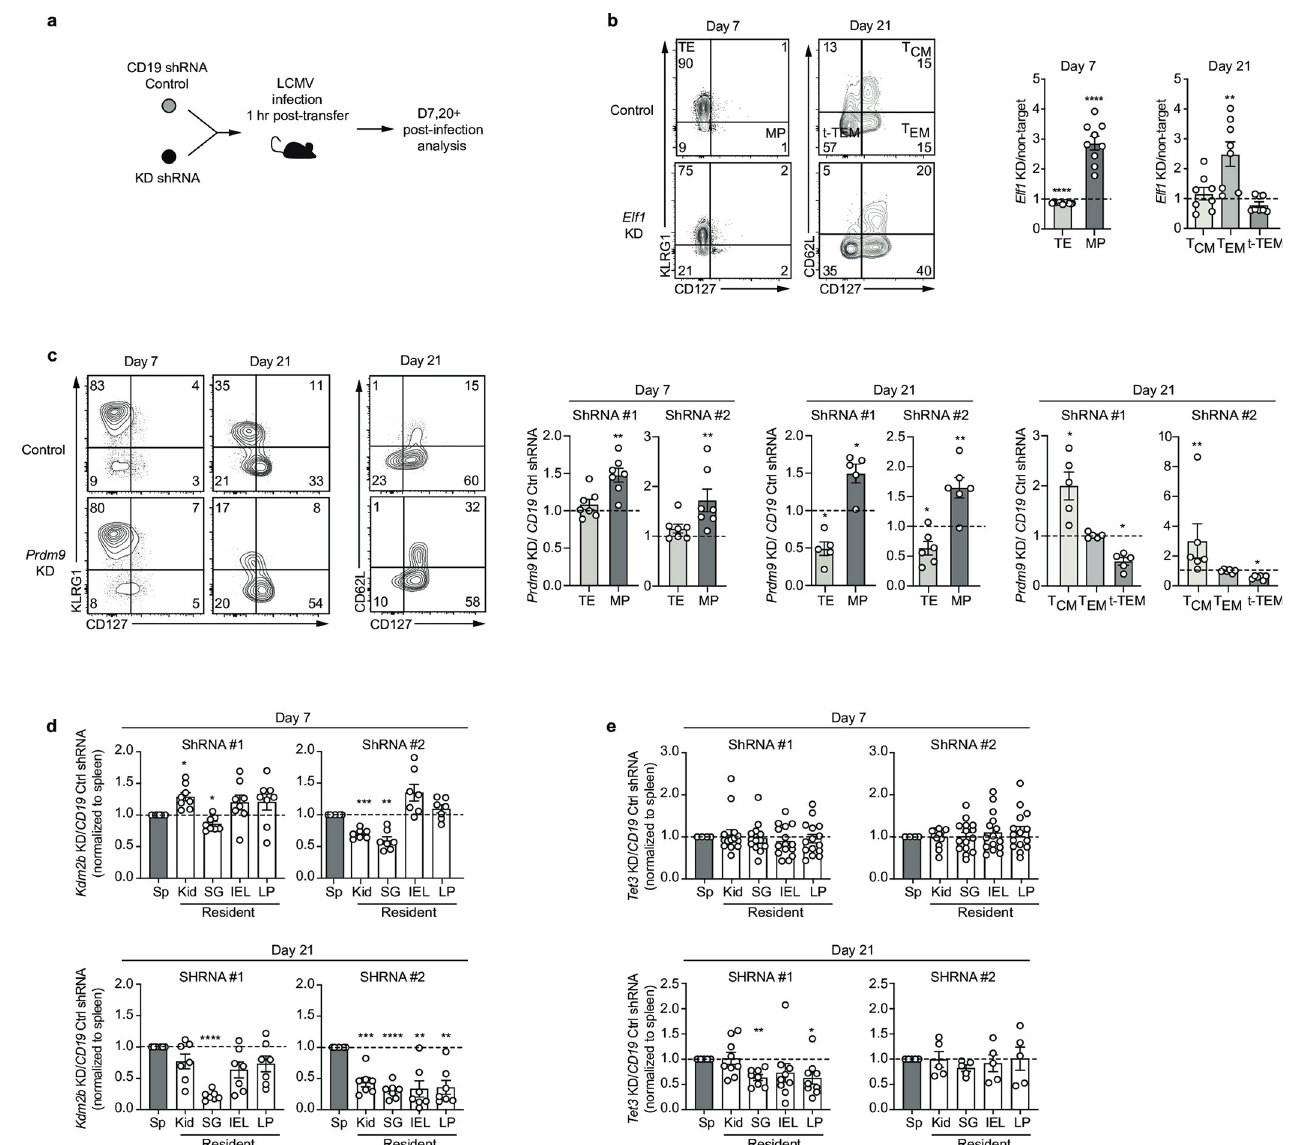
Fig 6. Validation of novel TFs’ roles in CD8 + T cell differentiation. (A) Experimental schematic in which congenically distinct P14 were transduced with gene-specific (knock-down, KD) or Cd19 control shRNA encoding retroviruses, mixed 1:1 then transferred into recipient mice subsequently infected with LCMV. (B) The ratio of TE (KLRG1 hi CD127 lo ) or MP (KLRG1 lo CD127 hi ) and T CM (CD62L hi CD127 hi ), T EM (CD62L lo CD127 hi ) or t-T EM (CD62L lo CD127 lo ) (gating strategy, left) within the Elf1 KD and control P14 population recovered from the spleen on day 7 (middle) or day 21–27 (right) of infection. (C) Representative flow cytometry staining (left) and quantification of the ratio of TE and MP and T CM , T EM or t-T EM (right) within the Prdm9 KD and control P14 population recovered from the spleen on day 7 or day 21. (D) The ratio of recovered Kdm2b KD and control P14 cells in indicated tissues on day 7 (top) and 21 (bottom) of infection. (E) The ratio of recovered Tet3 KD and control P14 cells in indicated tissues on day 7 (top) and 21 (bottom) of infection. Data are cumulative of 2–3 experiments with n = 3–5 per group. Graphs show mean ± SEM. A one-sample two-tailed t-test, two-tailed ratio paired t-test (B,C) or a one- way paired ANOVA test (D,E) was used to determine statistical significance; � p < 0.05, �� p < 0.01, ��� p < 0.001, ���� < p <